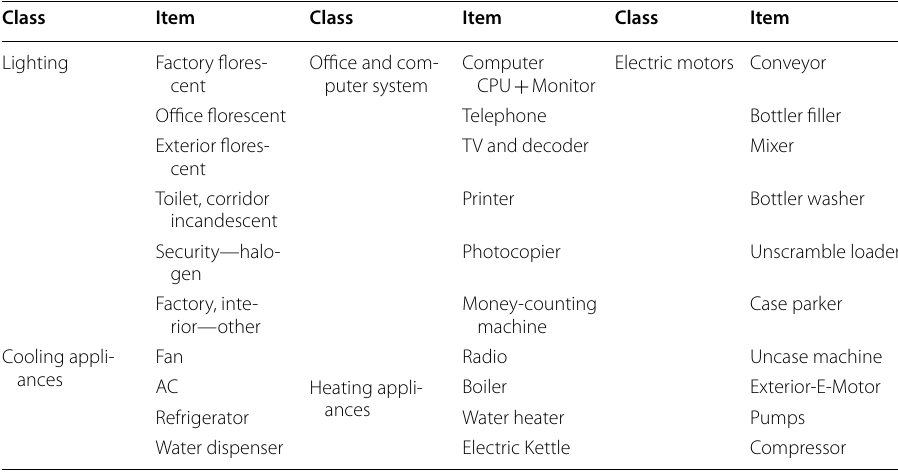
Table 1 Classification of electrical items within the industries Class